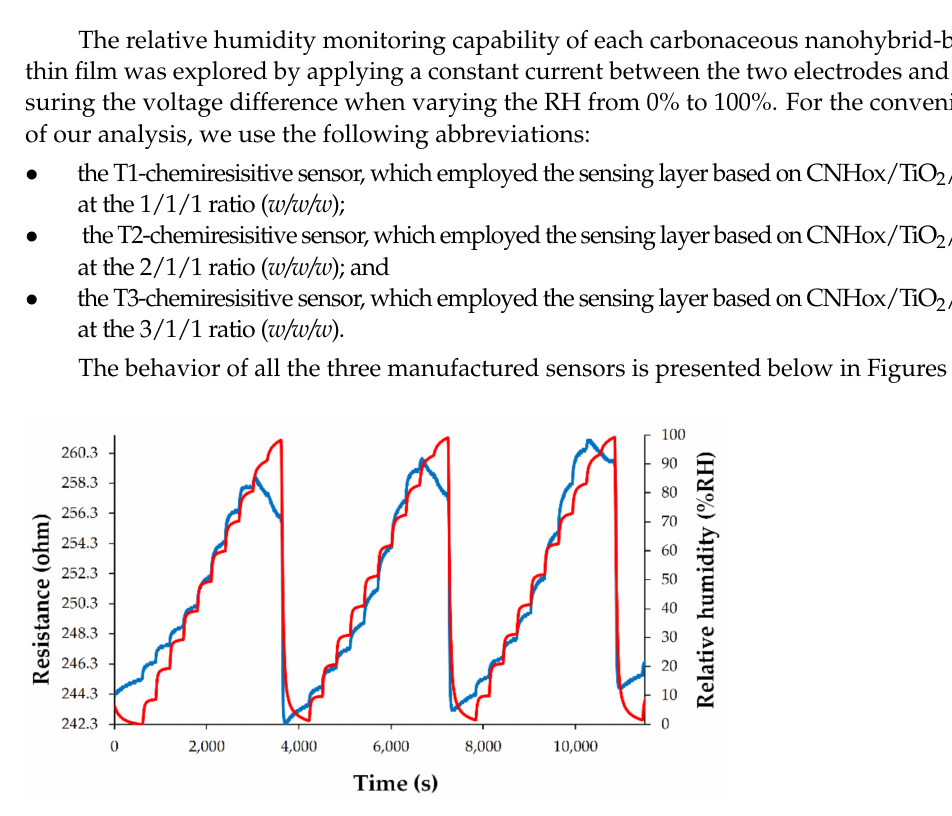
Figure 9. The response of the sensor T1 (the blue curve) as a function of time for the three full measurement cycles when RH varies between 0% and 100%. The “RH curve-red” shows the variation of the RH in the testing chamber, as indicated by the reference